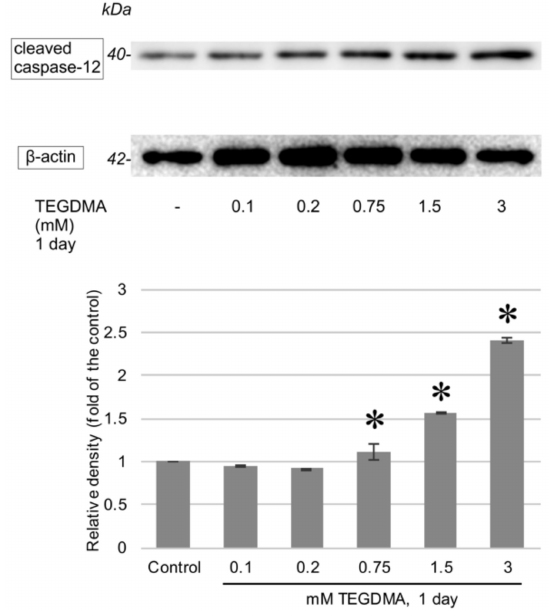
Figure 8. Immunoblots showing the changes in the levels of cleaved caspase-12 after a 1-day exposure to 0.1, 0.2, 0.75, 1.5, and 3 mM TEGDMA. β -actin bands, obtained by reprobing the Western blot membrane, served as a loading control each time. Results of the quantitative analysis of densitometry data are illustrated below the blot. * = significantly different from the untreated control ( P = 0.0074, P < 0.0001, and P < 0.0001 at 0.75 mM, 1.5 mM, and 3 mM, respectively, sample number: n = 3).